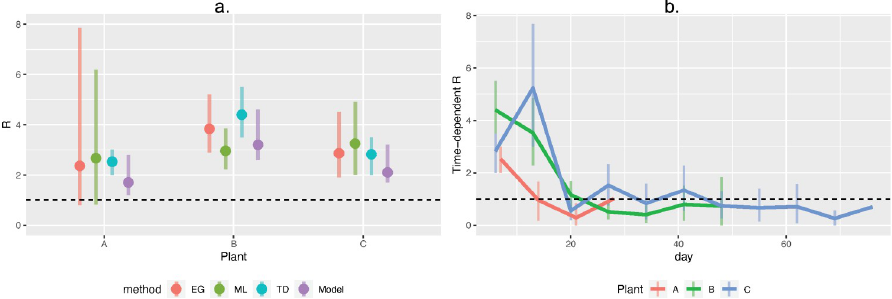
Fig 6. R estimates. a) Comparison of R estimates using different estimation techniques. Colors indicate each technique: EG: Exponential growth; ML: Maximum likelihood; TD: R-TD during the first week; Model: Estimate from the tuned compartmental model. b) Time-dependent R estimated at a weekly interval for each plant. In both panels, black hashed line shows R =